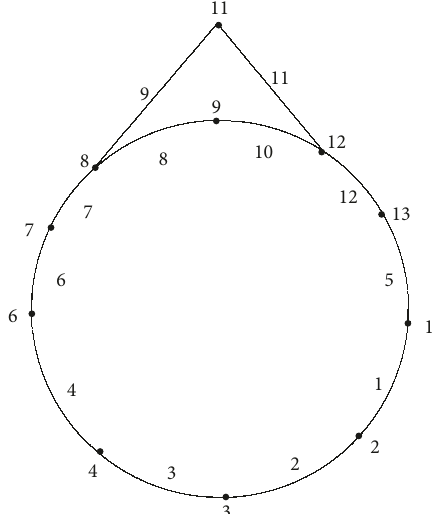
Figure 9: A classical mean labeling of G obtained by duplicating a vertex of cycle C